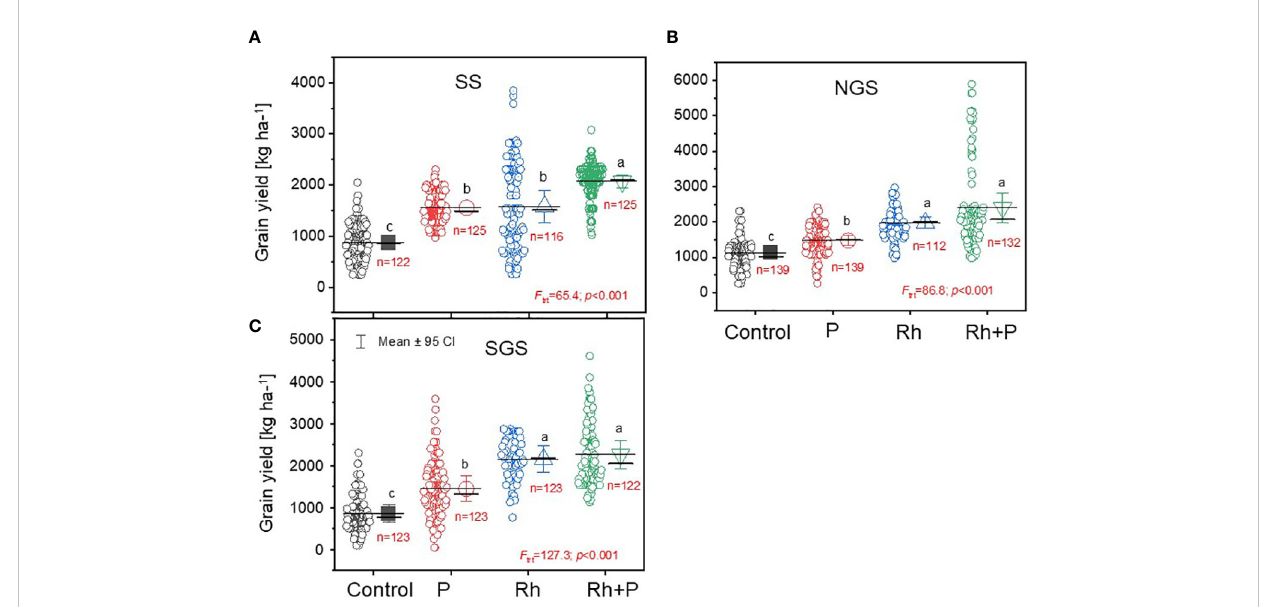
FIGURE 3 Boxplots of the soybean yield (kg ha − 1 ) for the control, phosphorus (P) fertilizer, rhizobia (Rh) inoculants, and the Rh + P combination in the (A) Sudan Savanna (SS), (B) Northern Guinea Savanna (NGS), and (C) Southern Guinea Savanna (SGS) of agroecology of Nigeria. Mean and ±95% con fi dence intervals are presented. Mean values appended by a different letter indicate signi fi cant differences at P<